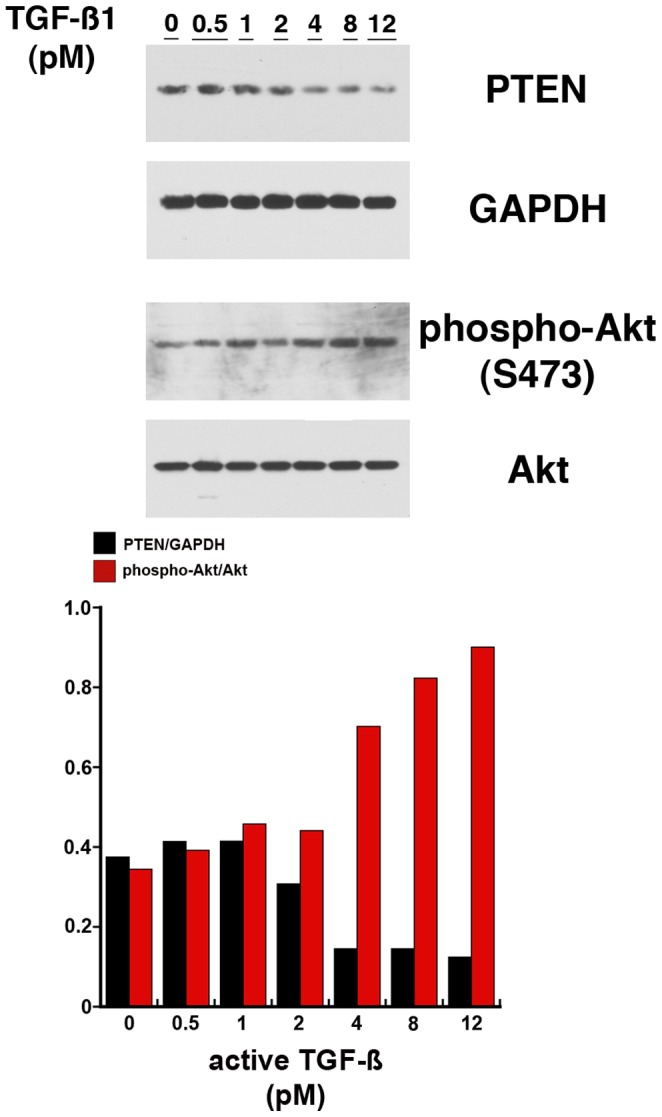
Macrovascular endothelial cells (HUVEC) incubated overnight in medium supplemented with increasing amounts of active TGF-ß1 demonstrate a dose-dependent reduction in PTEN and a corresponding increase in phospho-Akt(S473).Error bars were not included as this experiment was performed once.